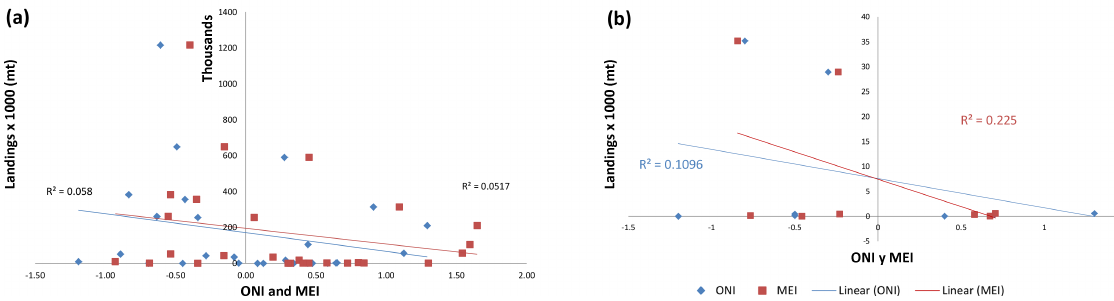
Figure 8. Annual landings of South American pilchard vs. ONI/MEI (1981–2006) and Q 1 landings vs. Q 4 ONI/MEI